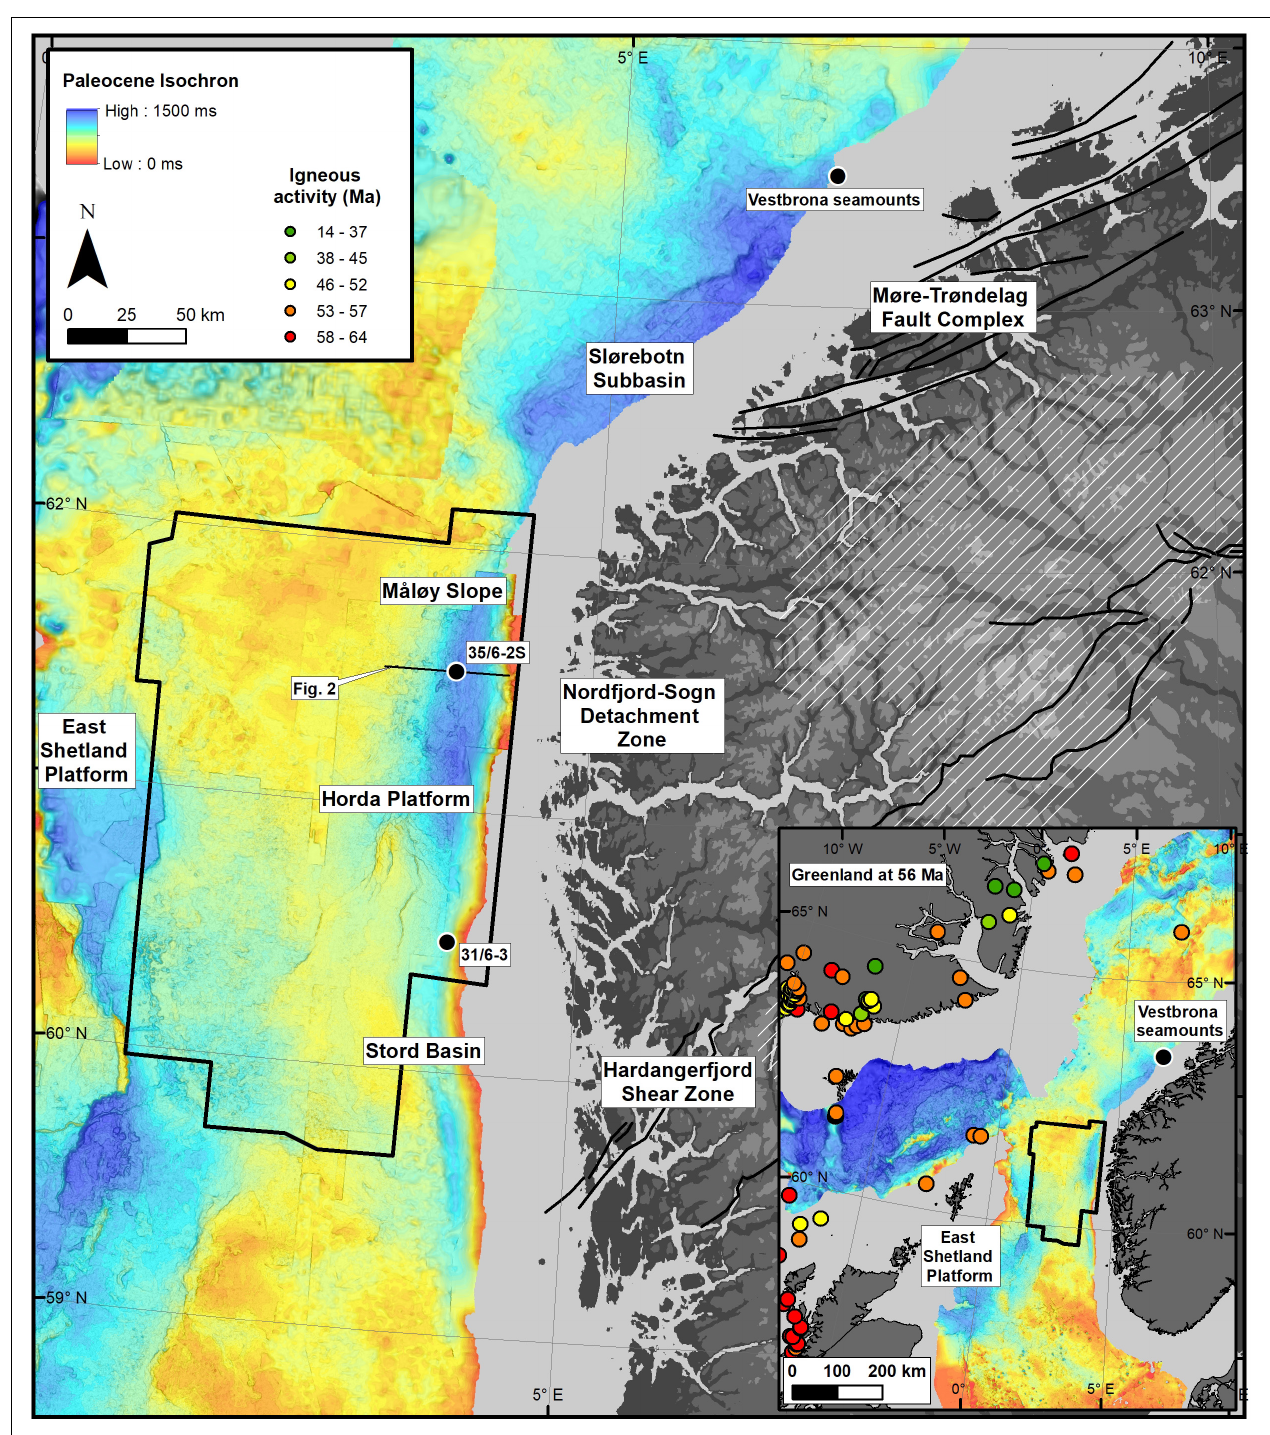
FIGURE 1 | Overview of the study area and regional isochron map of Paleocene sediments. The black outline shows the extent of seismic survey CGG18M01 which has been used to map Paleocene and Eocene stratigraphic units. Black lines represent main faults. The NE-SW trending Hardangerfjord Shear Zone is believed to represent the most landward possible extent of the Paleocene catchment. The white hatched polygon represents the area of inferred high Paleocene topography as suggested by Sømme et al. (2013b). Inset map shows reconstructed North Atlantic plate setting at 56 Ma with the distribution of igneous ages for the North Atlantic Igneous Province (from Steinberger et al.,